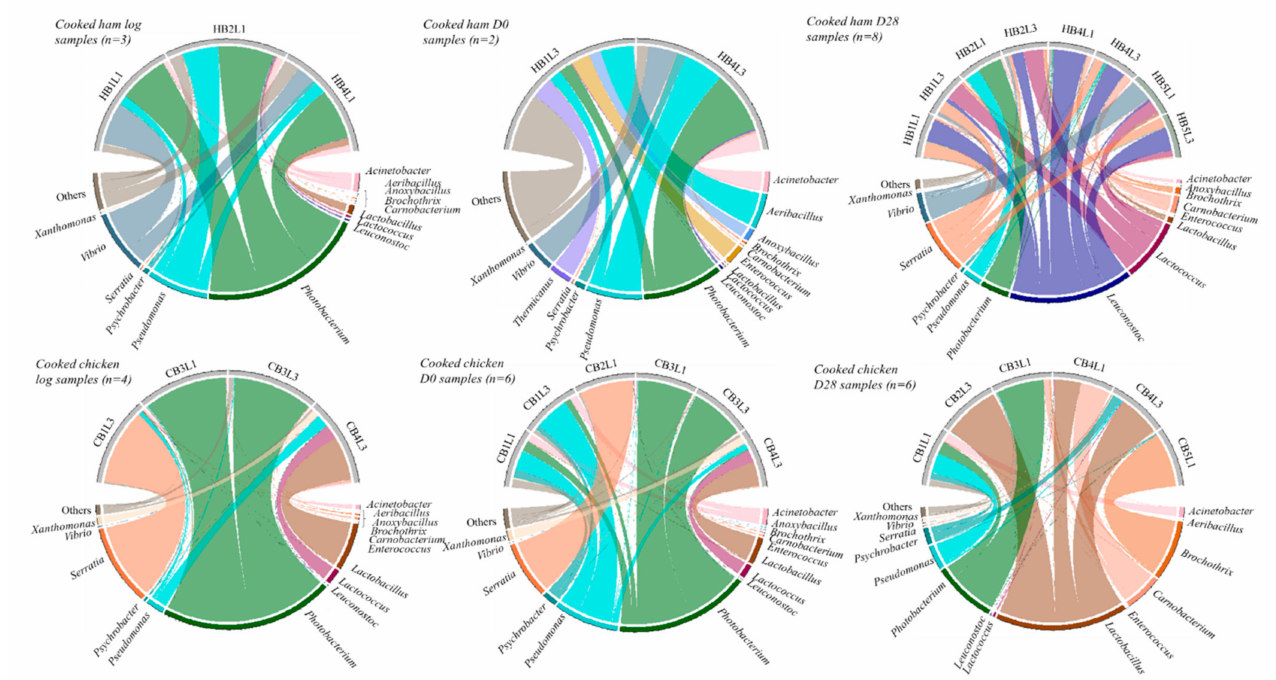
Figure 6. Chord diagrams of the relative abundance of taxa identified by metabarcoding at genus level for cooked ham and cooked chicken samples. The taxa representing <5% in relative abundance were merged in the category “Others”. Sample codes: H, cooked ham; C, cooked chicken; B, batch number; L, time of slicing at either one (L1) or three weeks after log production (L3); and D, time of analysis at either the day of slicing (D0) or after 28 days of storage